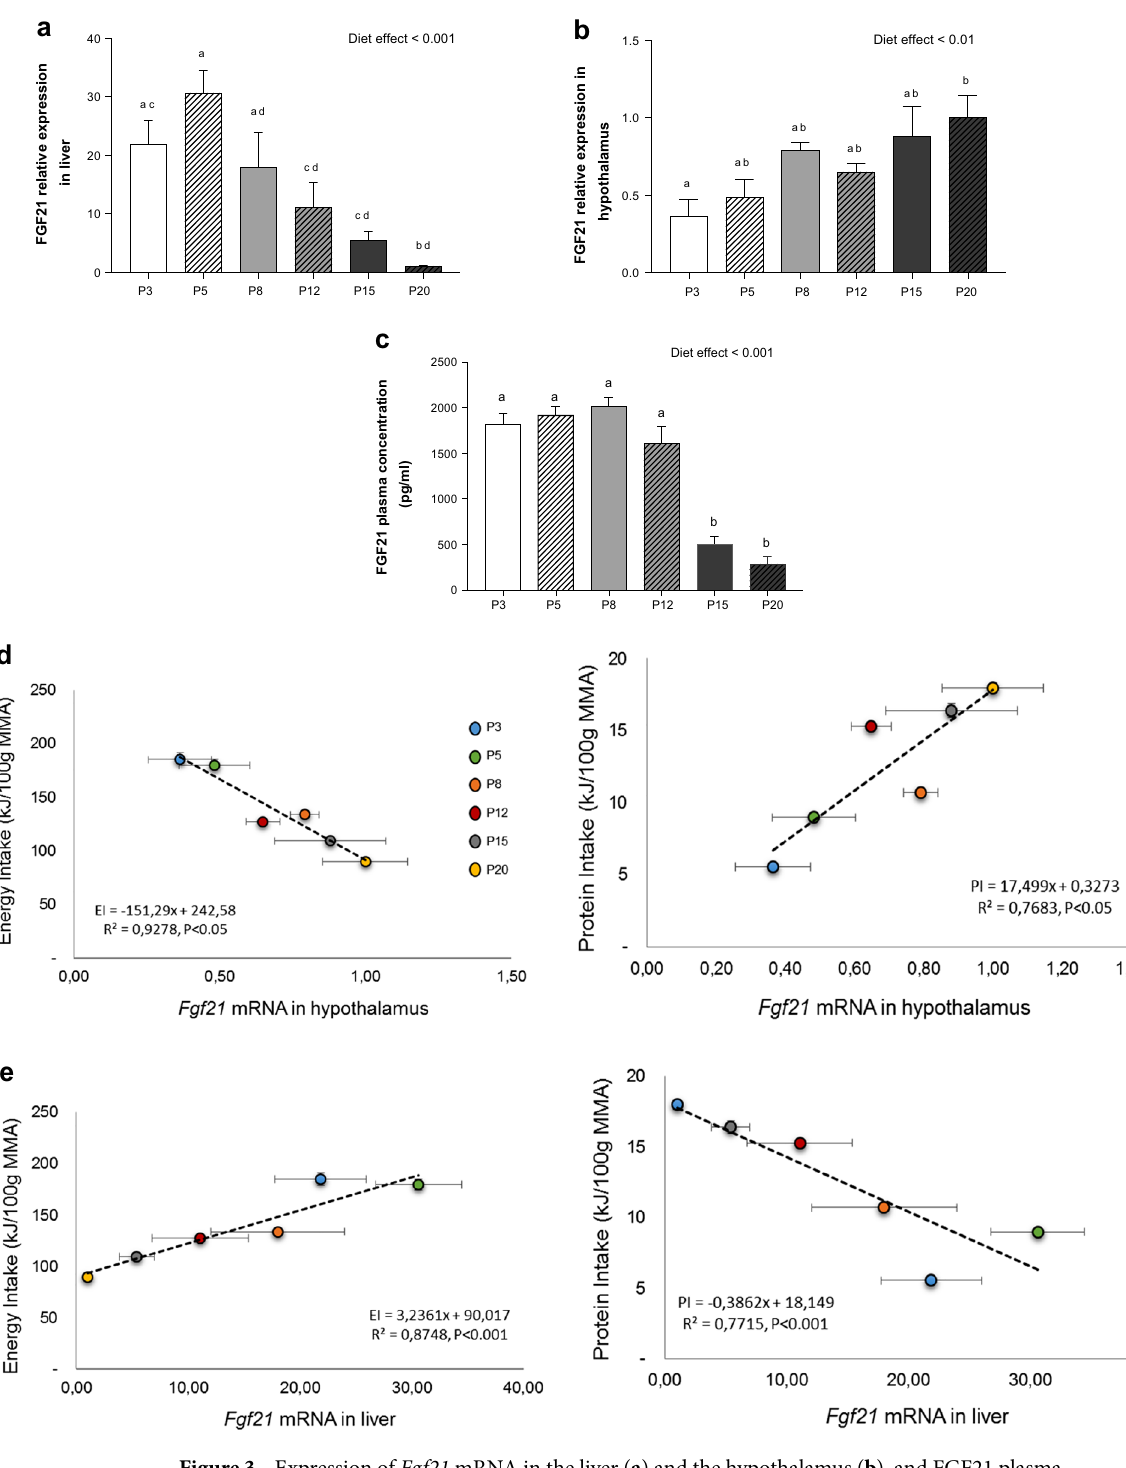
Figure 3. Expression of Fgf21 mRNA in the liver ( a ) and the hypothalamus ( b ), and FGF21 plasma concentrations ( c ) two hours after ingestion of a 4 g test-meal. Correlations between mean group values of Fgf21 mRNA hypothalamus values vs energy intake (EI) and protein intake (PI) ( d ), and correlation between Fgf21 mRNA liver vs energy intake and protein intake ( e ). Values are means ± SEM (n = 6 per group). a,b,c,d Data that do not share the same letter are different at the P < 0.05